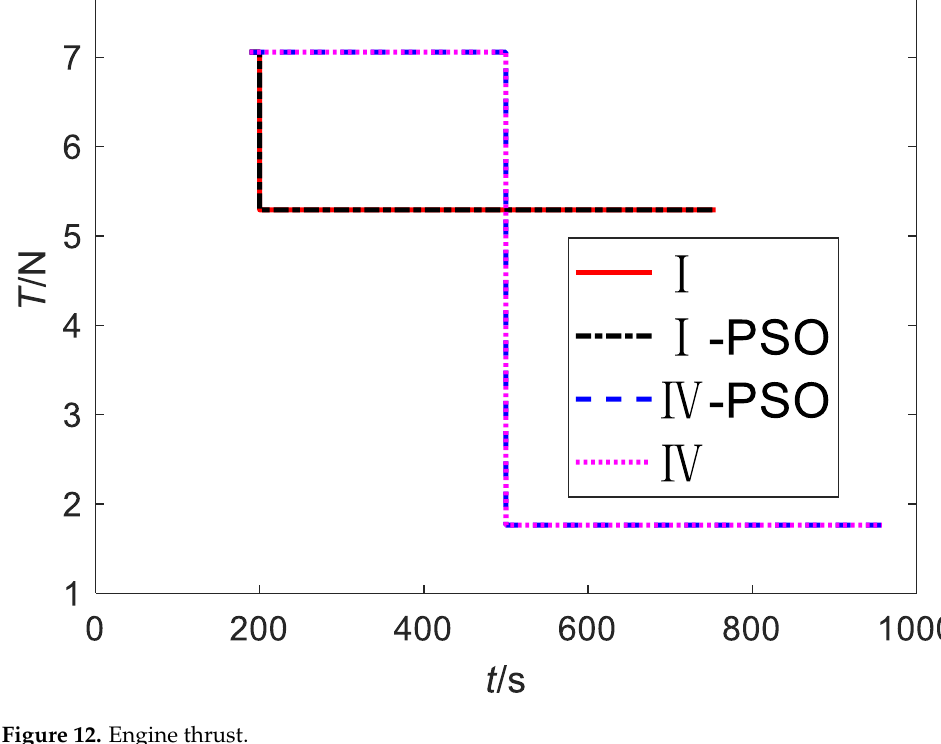
Figure 12. Engine thrust .